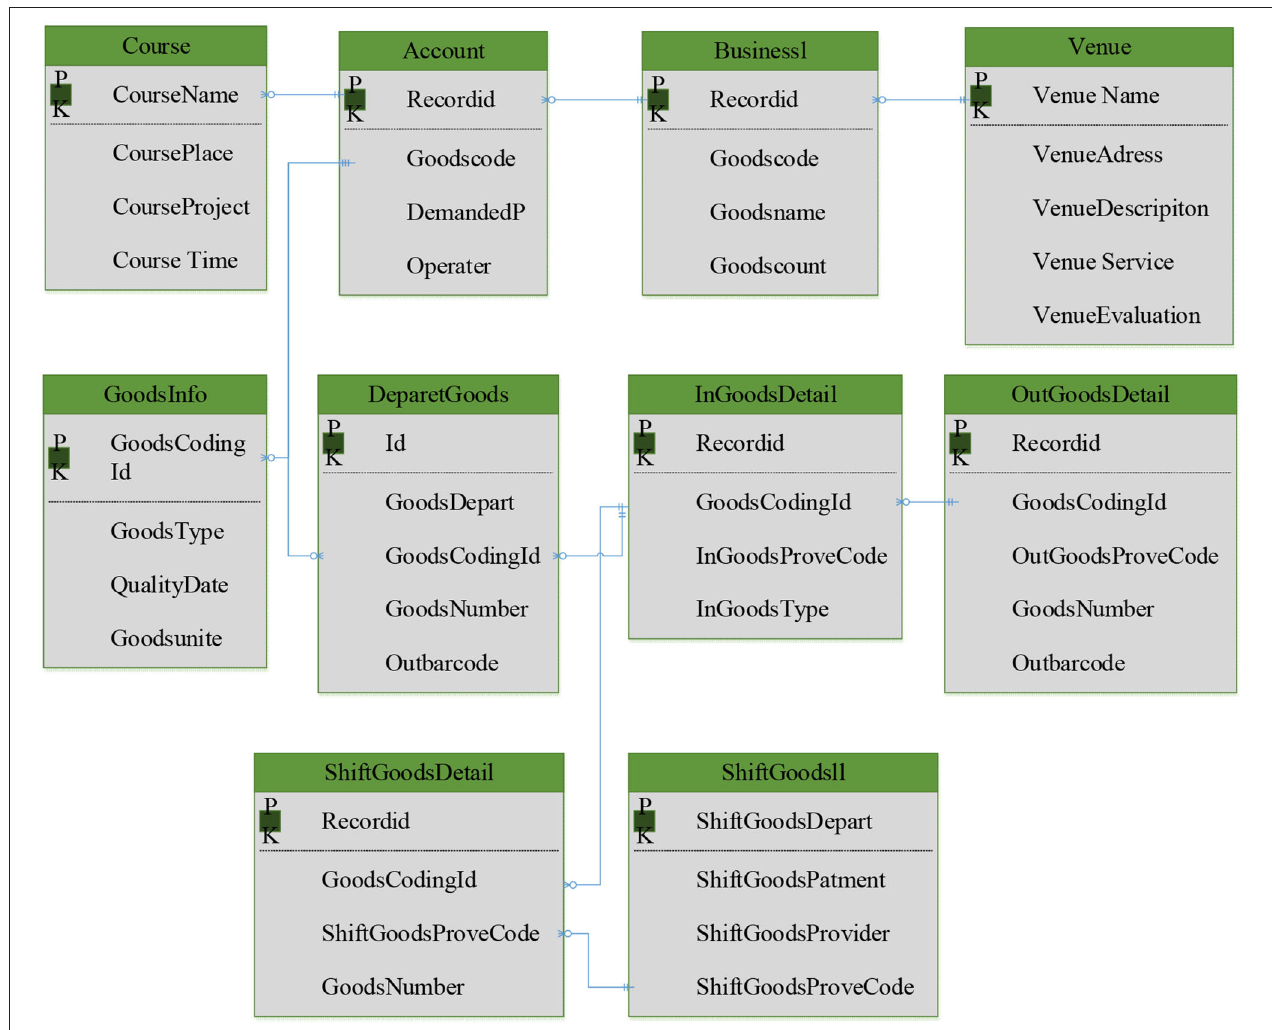
FIGURE 8 | Relationship model of system